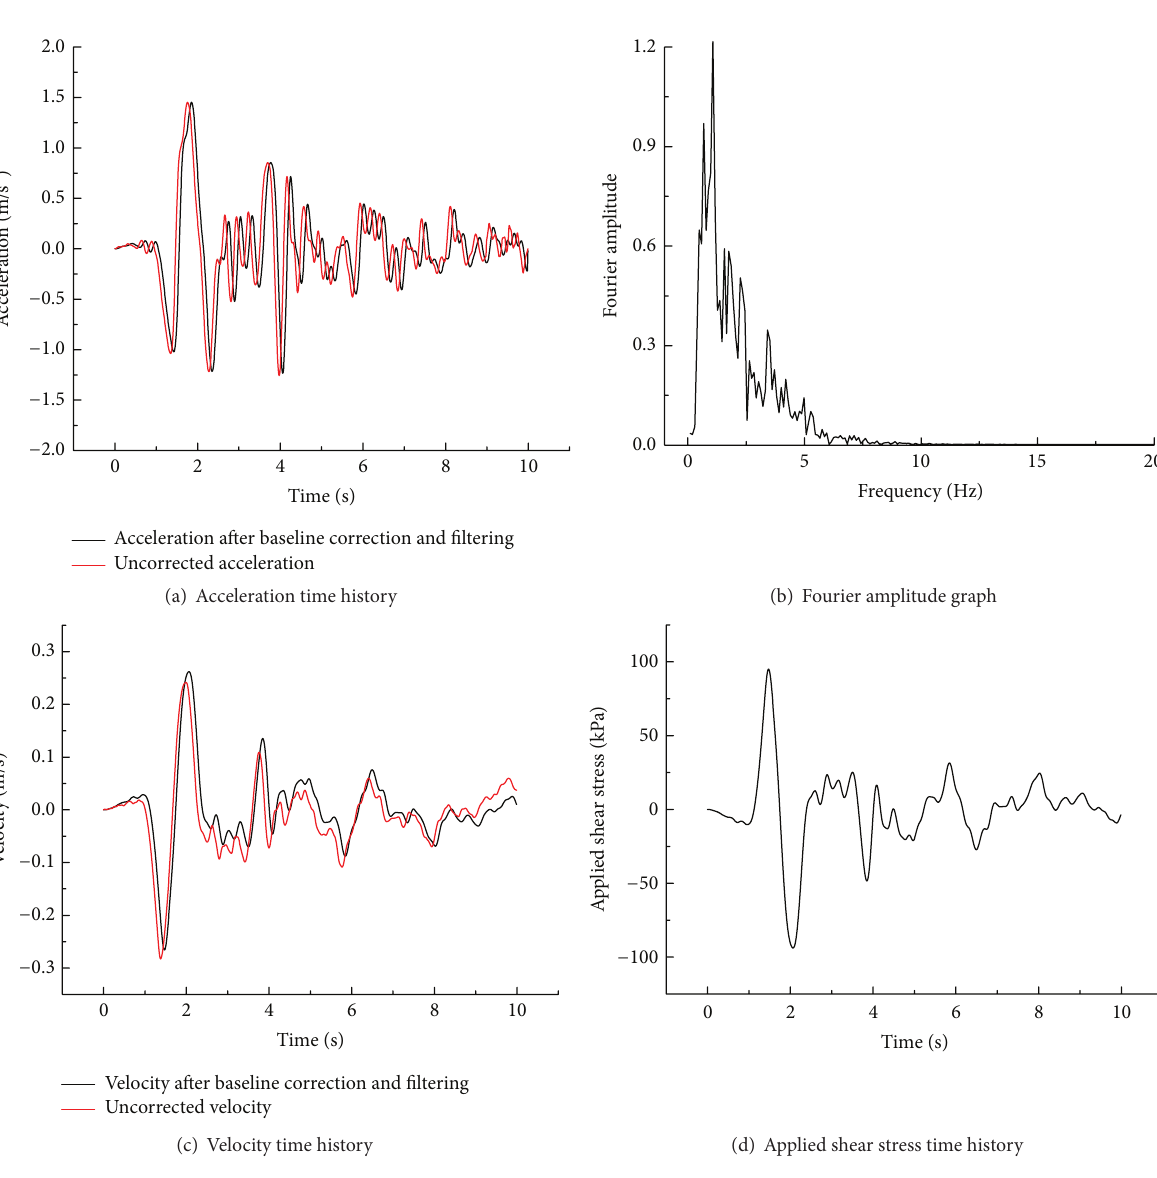
Figure 11: Tianjin seismic